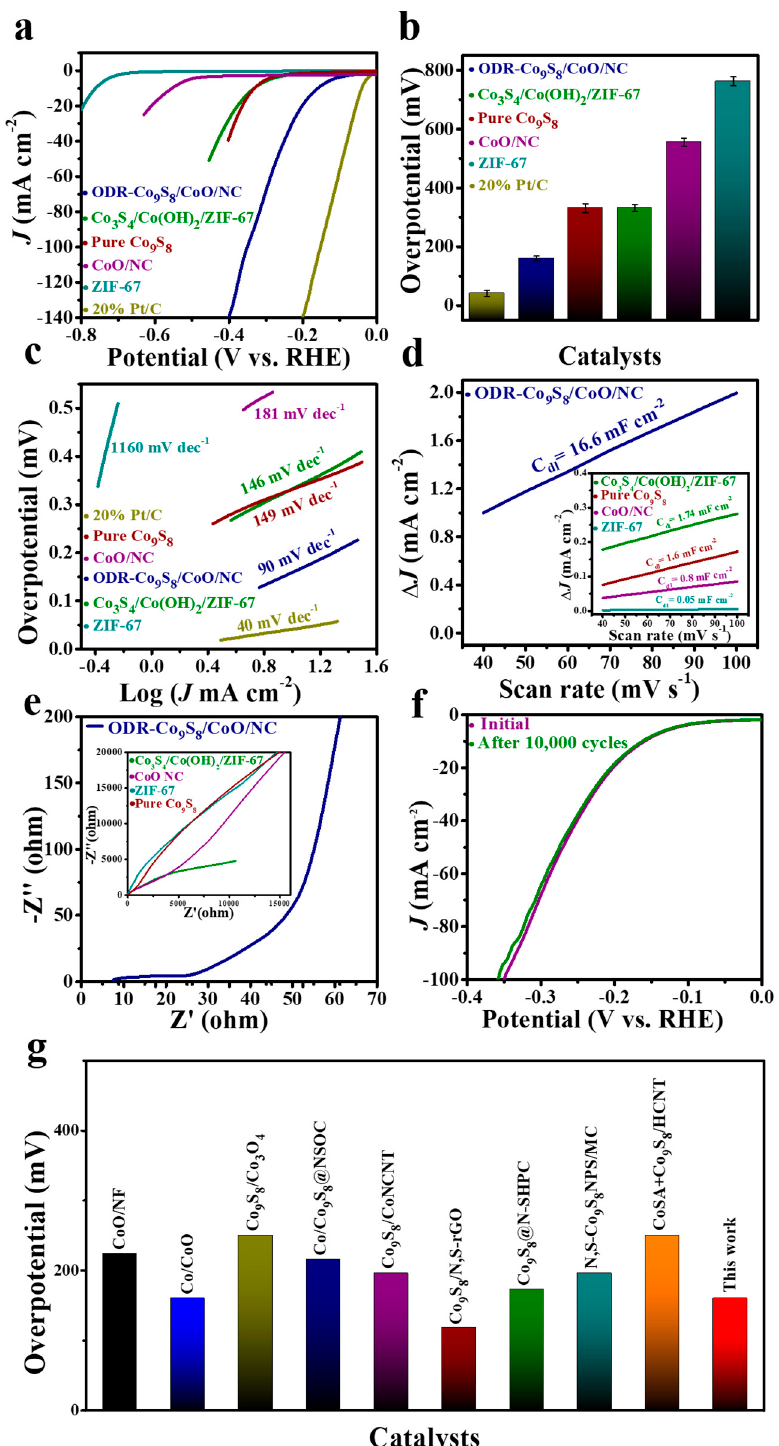
Figure 5. ( a ) HER performance, ( b ) Overpotential comparison (The error bar represents the range of results from three independent measurements). ( c ) Tafel slope of ODR-Co 9 S 8 /CoO/NC, 20% Pt/C, Co 3 S 4 /Co(OH) 2 /ZIF-67, ZIF-67, Co 9 S 8 , and CoO/NC in 0.1 M KOH. ( d ) Capacitive current measurements ( Δ J 0 = J a − J c ) and ( e ) Nyquist plots for ODR-Co 9 S 8 /CoO/NC, Co 3 S 4 /Co(OH) 2 /ZIF-67, ZIF-67, Co 9 S 8 and CoO/NC. ( f ) Durability of ODR-Co 9 S 8 /CoO/NC electrocatalyst after first and 10,000th CV cycles. ( g ) Overpotential comparison of the as-prepared catalyst with previously reported Co-based compounds at J HER = 10 mA cm − 2 .